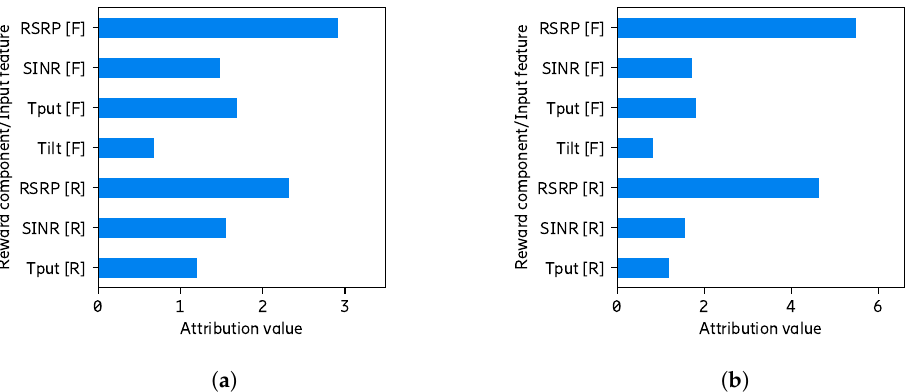
Figure 7. The normalized explanations where the importance of the input features and the reward components are compared in the same plot. ( a ) Normalized explanation at the Q-function level. ( b ) Normalized explanation when the reward weight is applied (at